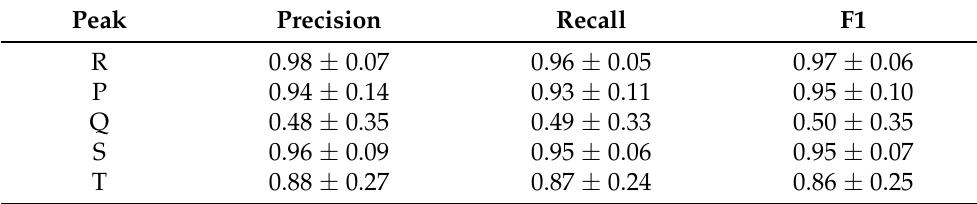
Table 4. Precision, recall, and F1 metrics for automated peak detection of each of the parts of the ECG waveform. These results were derived from the visual inspection of 10 randomly selected participants’ data. The Q peak shows the most vulnerability to noise, with the lowest precision, recall, and F1 values and the largest standard deviations in all